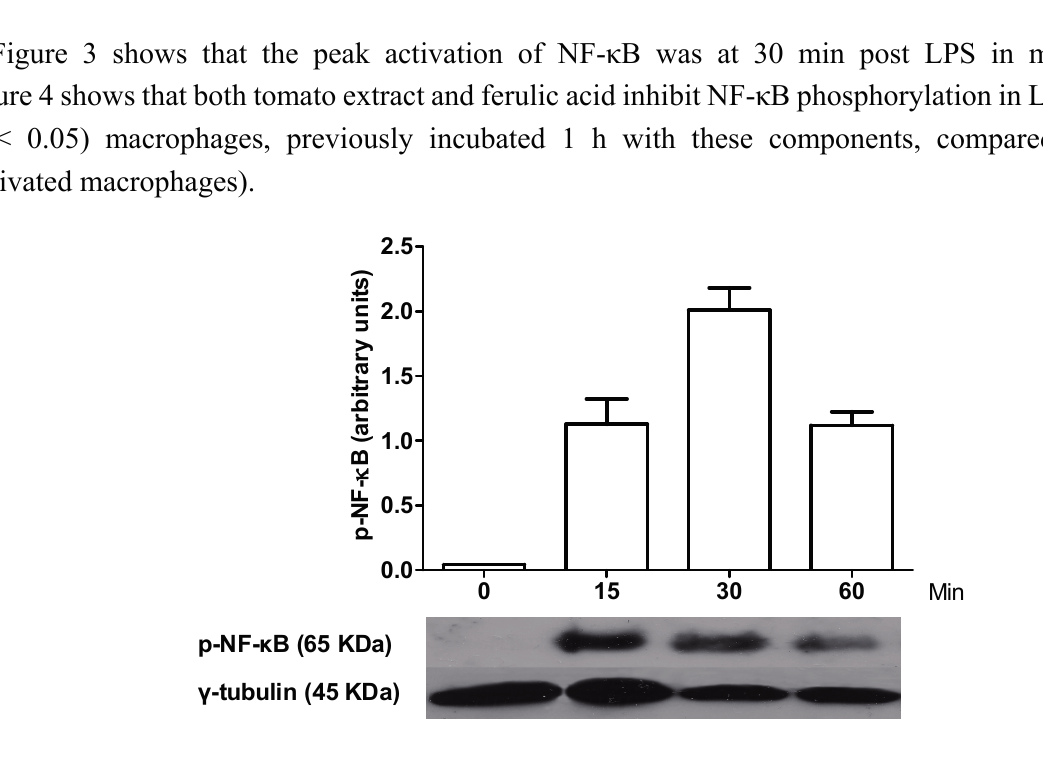
Figure 3. Kinetics of activation of NF- κ B in LPS-activated macrophages. It is observed that the peak of NF- κ B activation occurred at 30 min after the challenge with